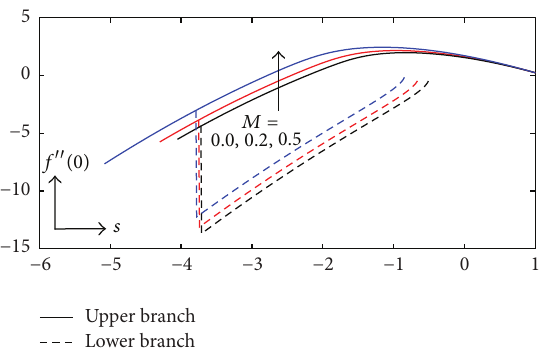
Figure 7: Velocity profiles for various values of 𝑀 with 𝑠 = −3 , 𝛾 = 0.5 , 𝜆 = 1 , and Pr = 3 .